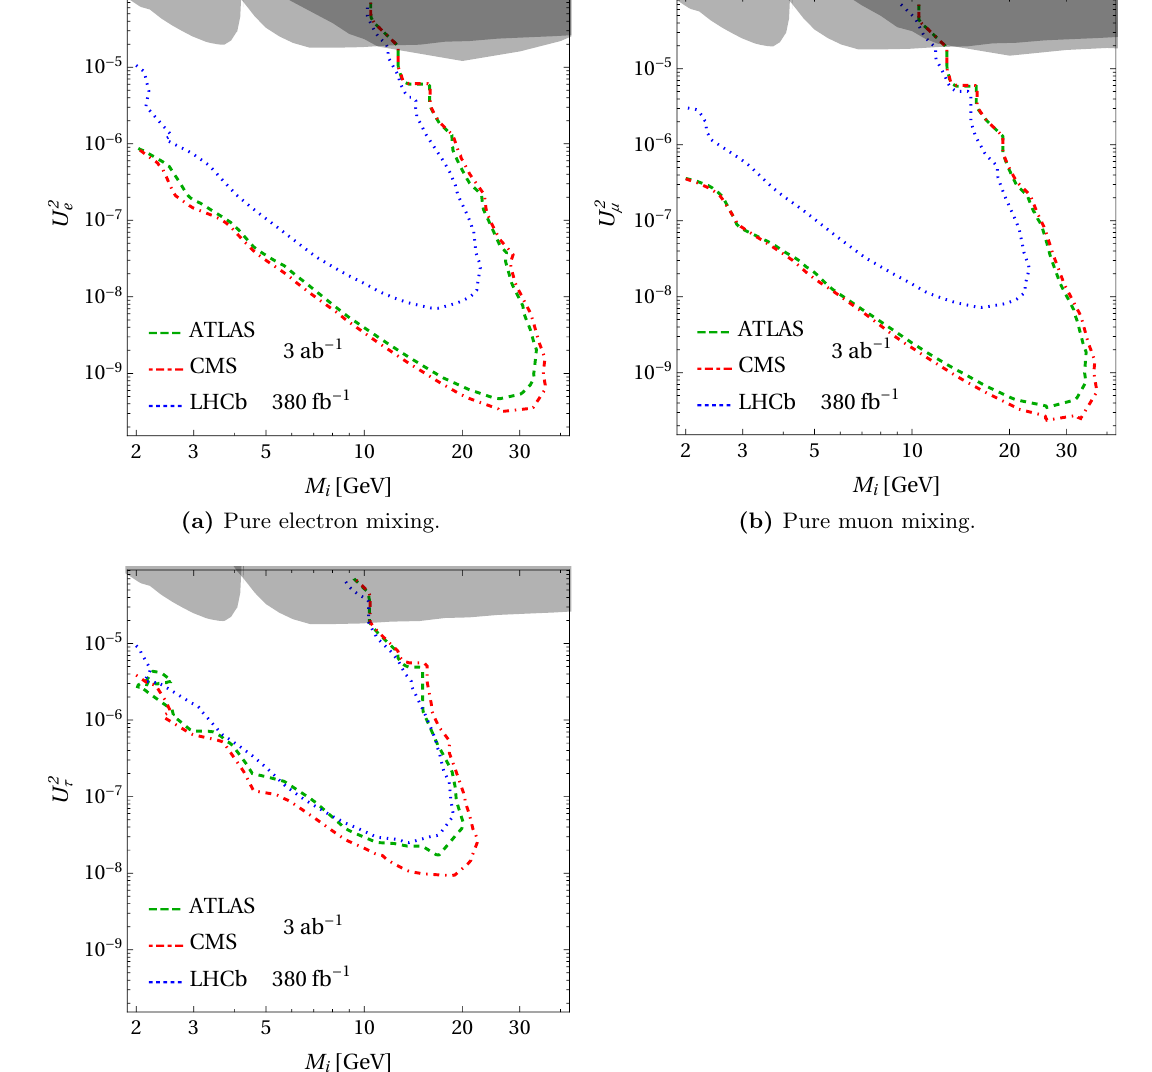
Figure 9. Exclusion reach of ATLAS, CMS with 3 ab (cid:0) 1 and LHCb with 380 fb (cid:0) 1 for the HL-LHC under ideal conditions for pure electron, muon and tau mixing in panel (a), (b) and (c), respectively.